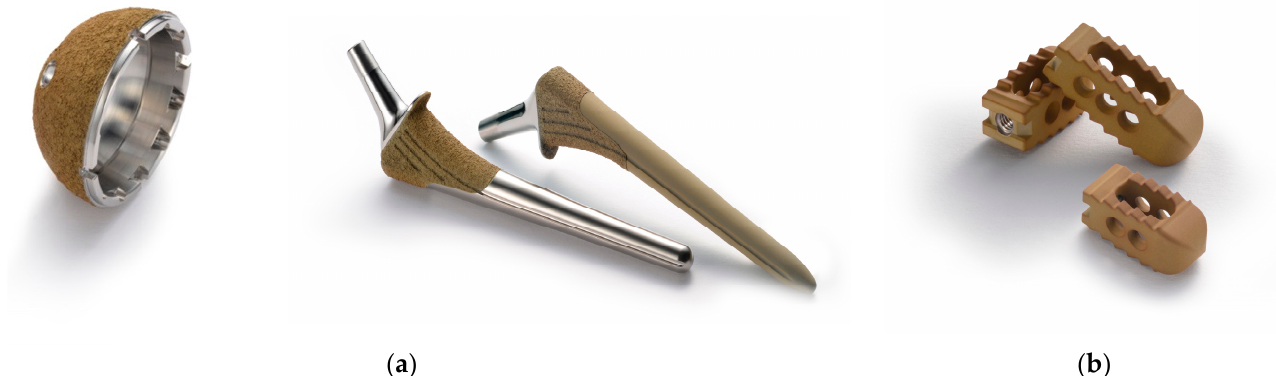
Figure 1. Silver-containing hydroxyapatite (Ag-HA) coating hip system (cup and stem) ( a ) and lumbar interbody cage ( b ).